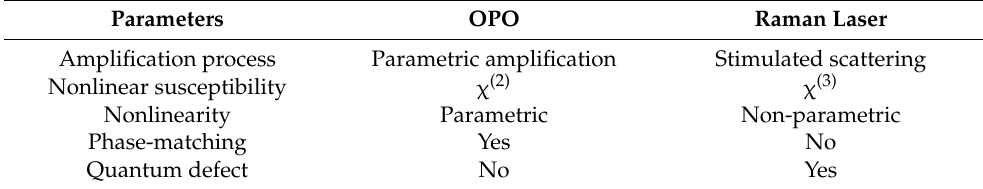
Table 1. Comparison of OPOs and Raman lasers. Parameters OPO Raman Laser Amplification process Parametric amplification Stimulated scattering Nonlinear susceptibility χ (2) χ (3) Nonlinearity Parametric Non-parametric Phase-matching Yes No Quantum defect No